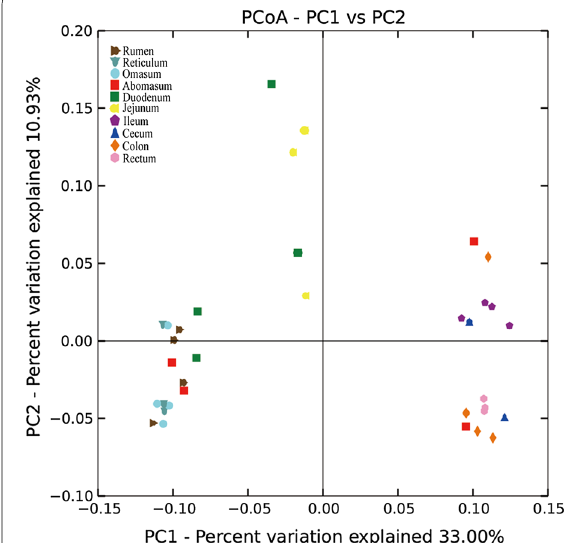
Fig. 1 The PCoA analysis of the GIT samples (unweighted UniFrac metric). The colored circles represent the gut microbiota from the rumen, reticulum, omasum, abomasum, duodenum, jejunum, ileum, cecum, colon, and rectum,